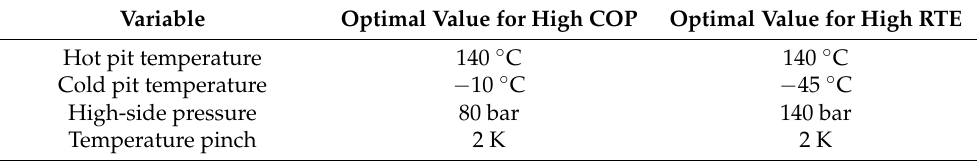
Table 3. Optimal values of variables.